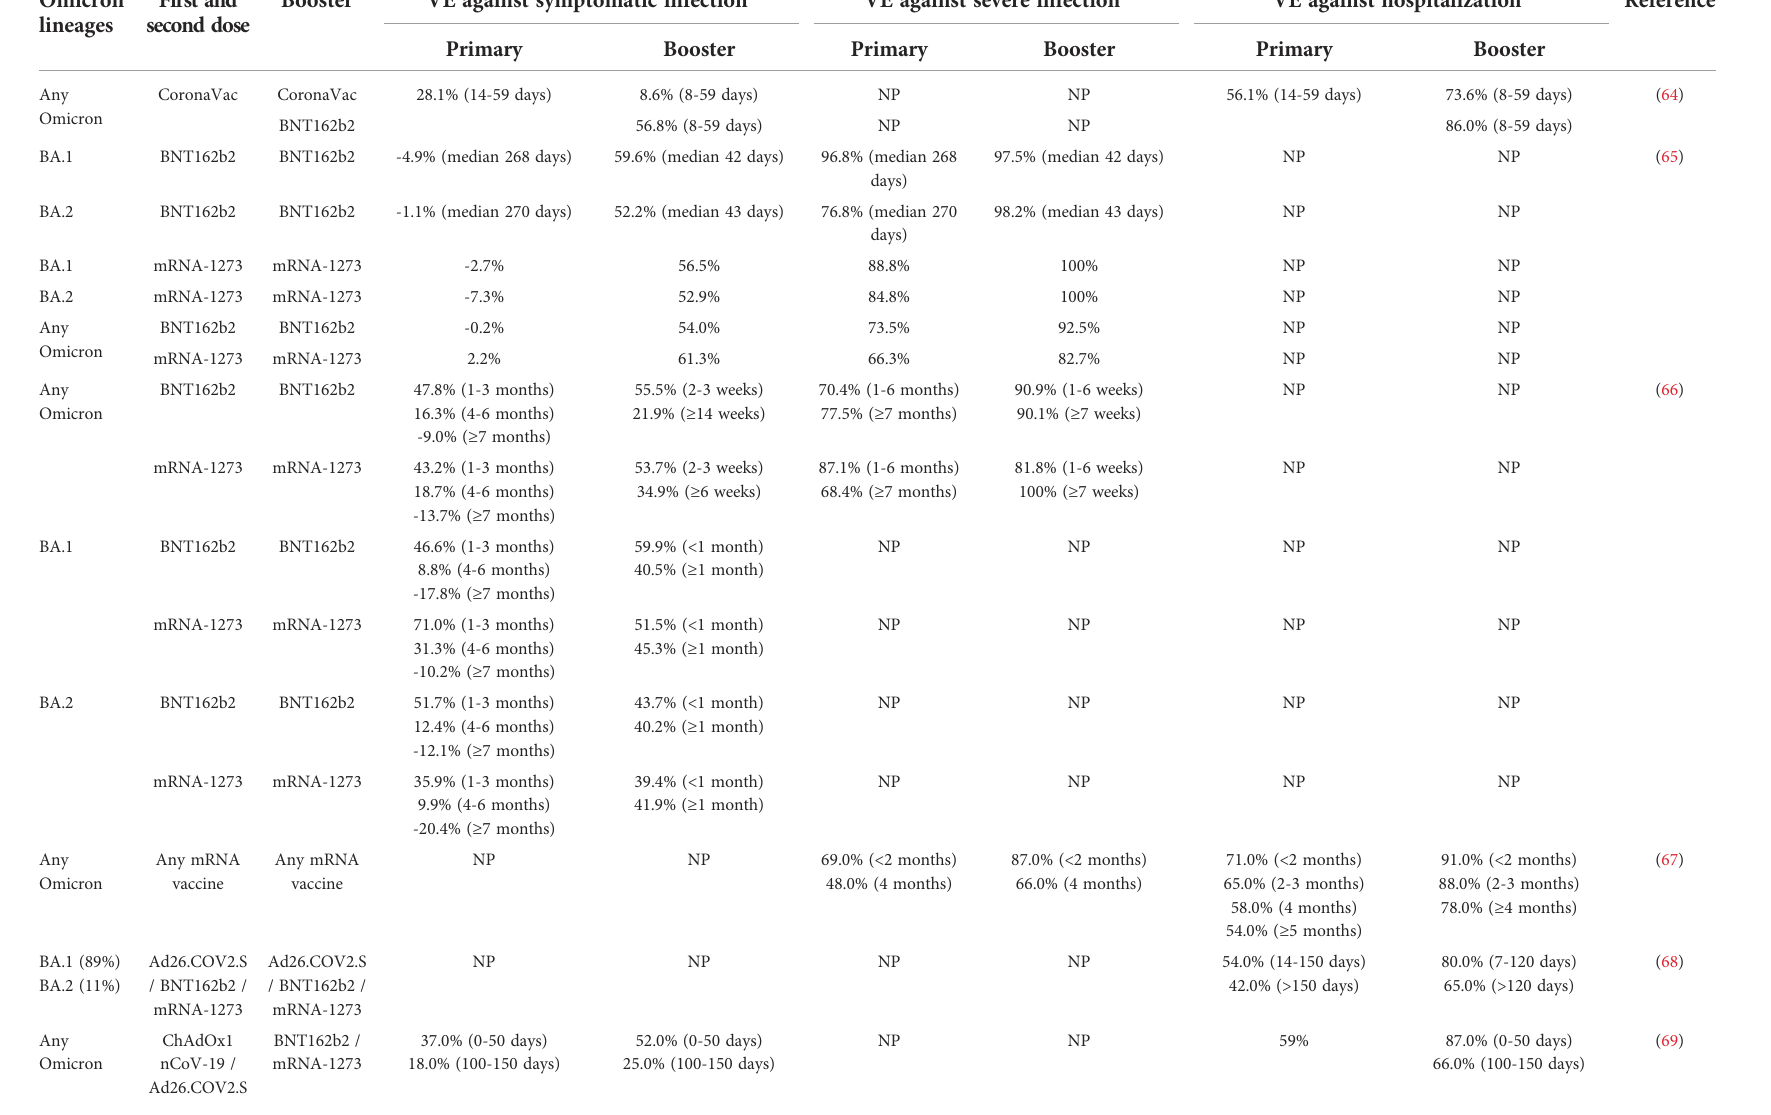
TABLE 1 Vaccine effectiveness of primary series and booster dose against Omicron